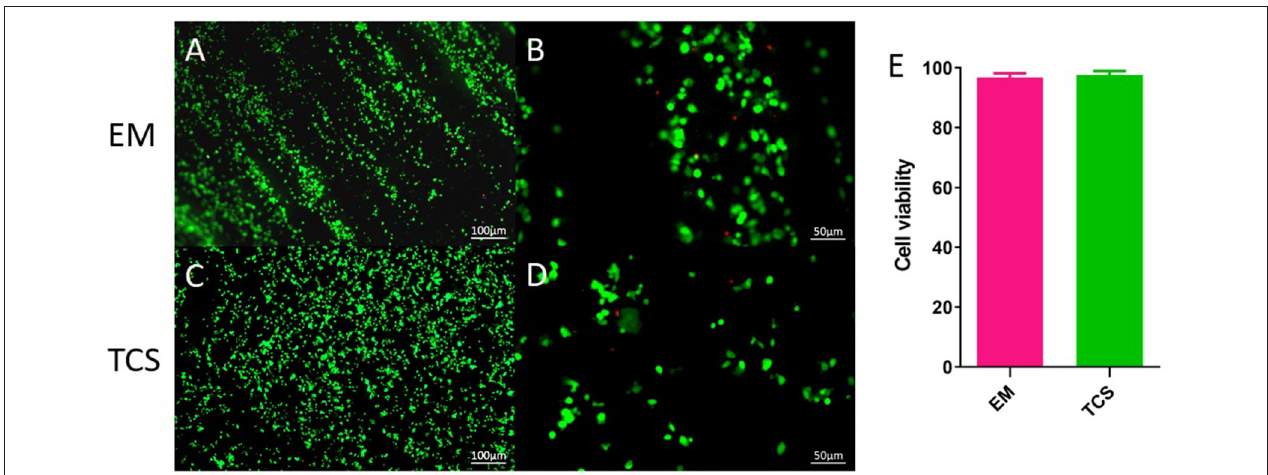
FIGURE 5 | Cell survival. (A–D) Live/dead staining; (E) cell viability. Scale bar: (A,C) 100 µ m, (B,D) 50 µ